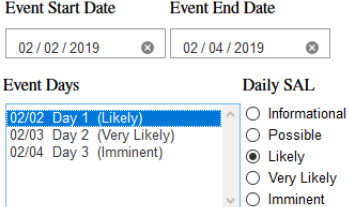
Figure A3. Setting subjective assessment of likelihood (SAL) values for a three-day